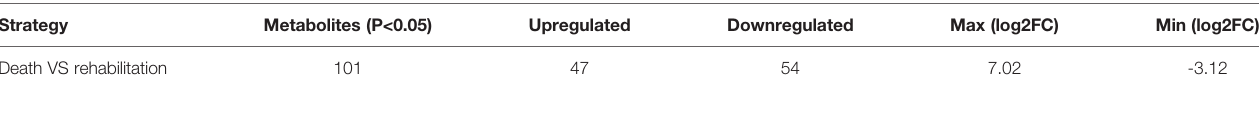
TABLE 3 | Comparison of metabolic differences between rehabilitation and